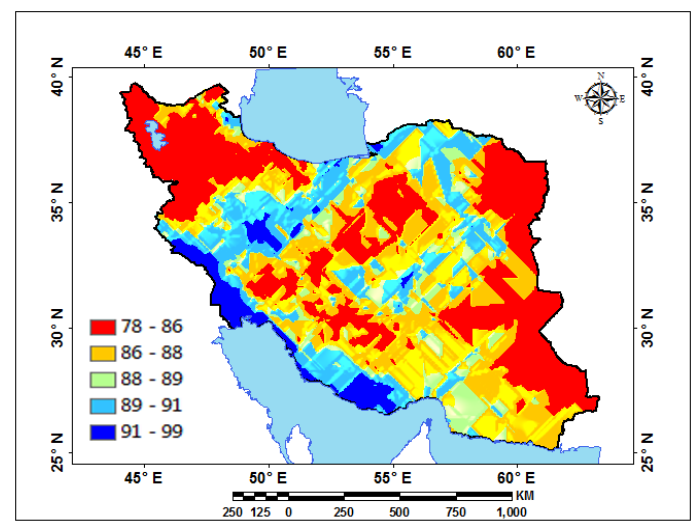
Figure 14. Forecast of autumn rainfall variations (seasonal additive model).